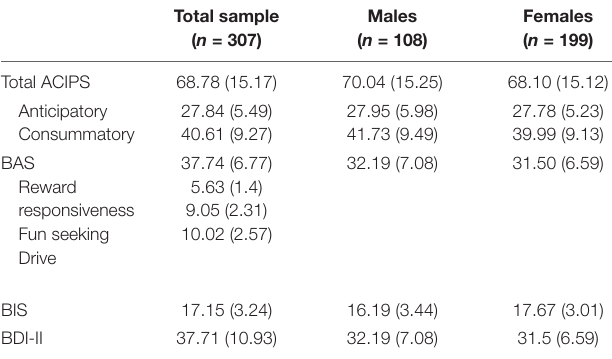
TABLE 4 | Descriptive statistics for the psychometric measures (Mean ± SD